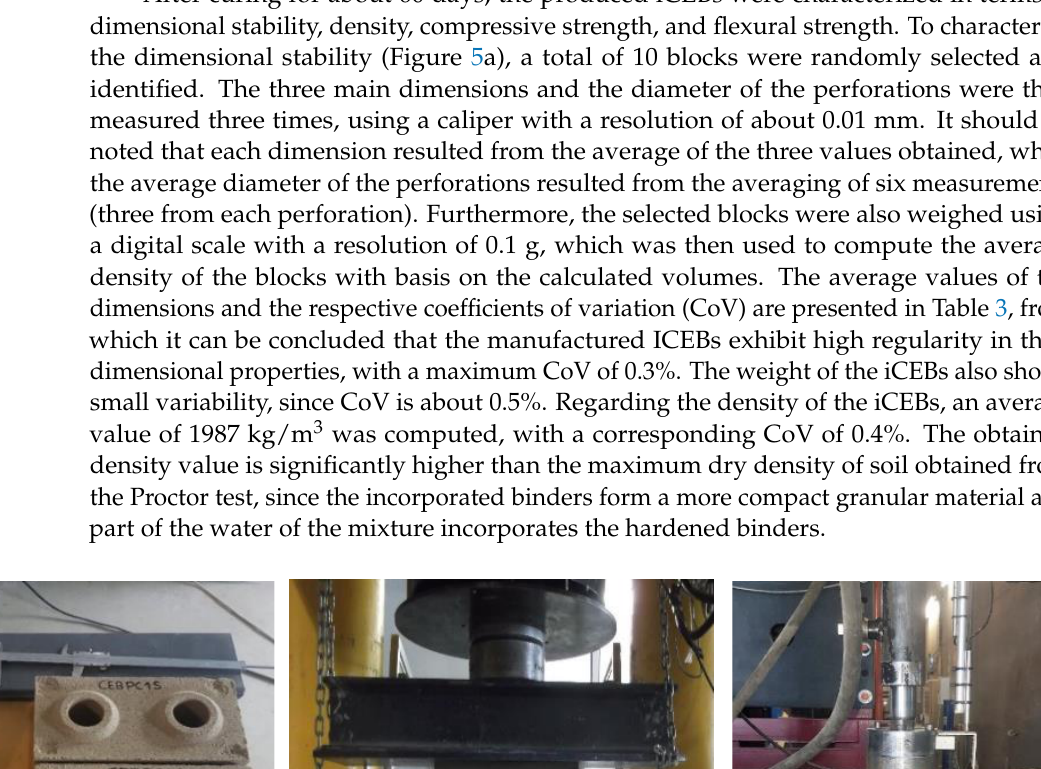
Figure 4. Building system adopted for the experimental program [45]: ( a ) geometry of the iCEBs and ( b ) running bond pattern for single-leaf and double-leaf walls.